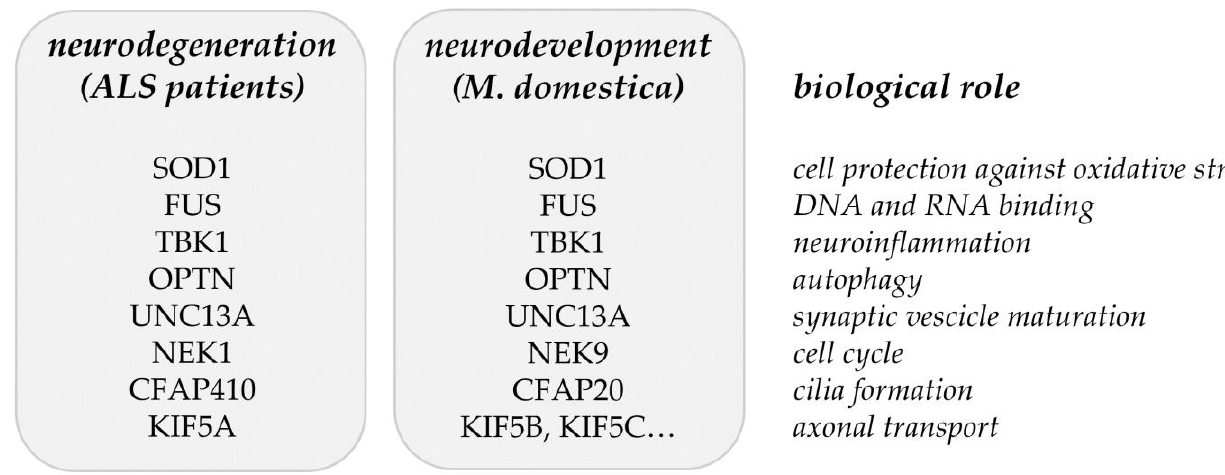
Figure 2. Matching genes/proteins identified through the common and rare variant association analyses from ALS patients [16] and the proteomic analysis of developing opossum spinal cord [17].